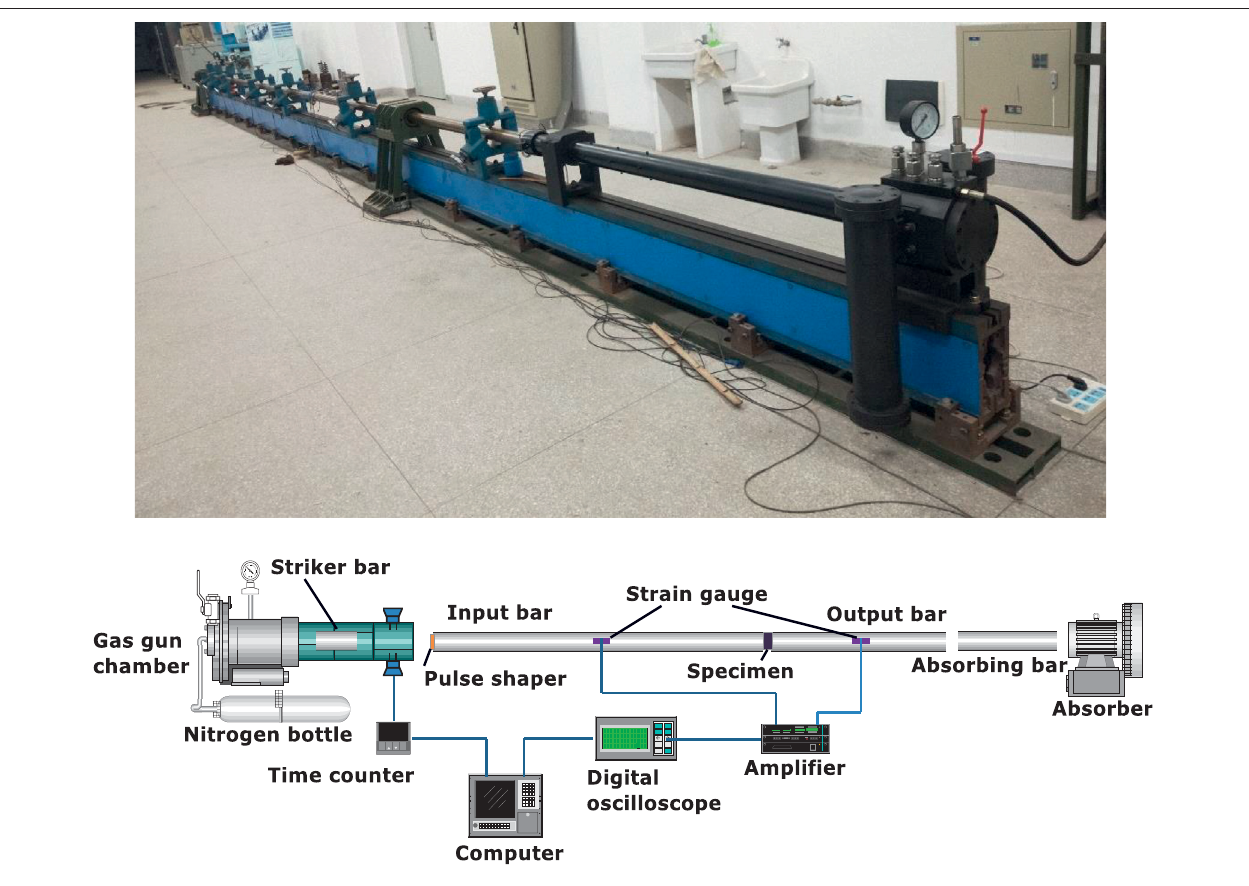
FIGURE 3 | Schematic diagram of Split-Hopkinson Pressure Bar.